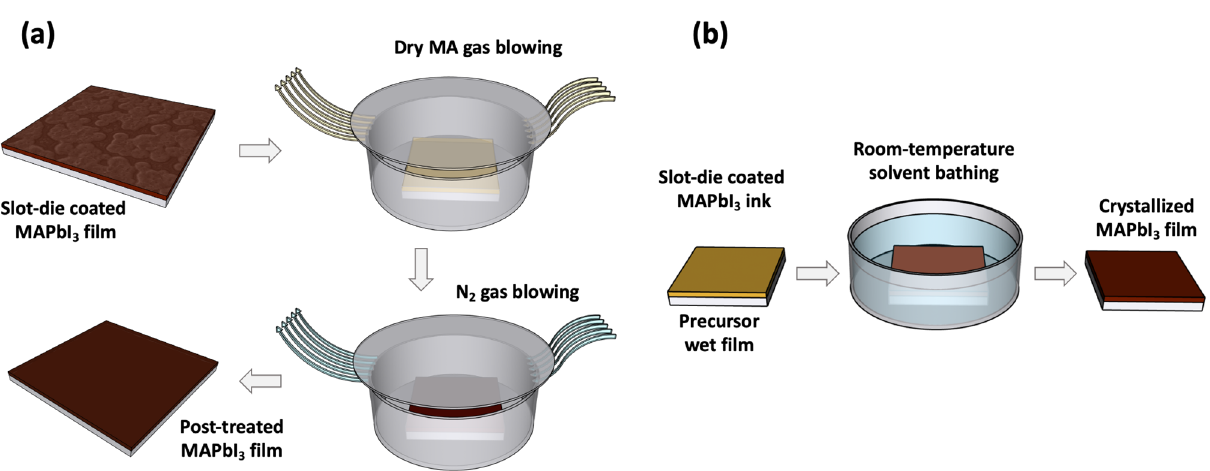
Figure 4. Schematic illustration showing: ( a ) MA-induced healing post-treatment performed on dry MAPbI 3 perovskite thin film and ( b ) anti-solvent dipping post-treatment on wet MAPbI 3 perovskite